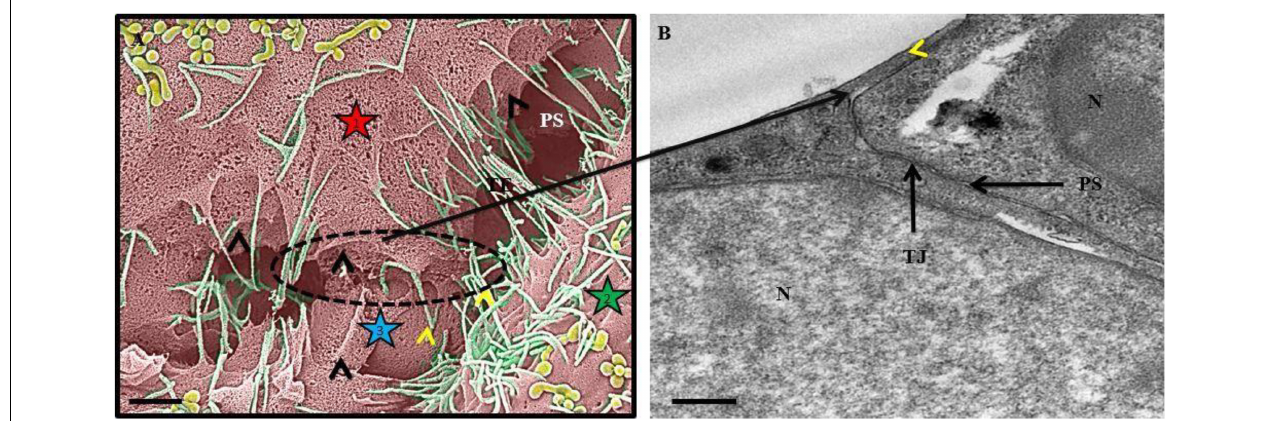
FIGURE 9 | An HRSEM and HRTEM micrograph of tethering nanotubule formation on b.End3 and b.End5 cells. In (A) the HRSEM micrograph depicts the formation of membrane tethers which progress into overlapping leaflets between adjacent b.End5 (BECs). The “ black arrowheads ” indicate direct cell-to-cell communication by way of lateral cytoplasmic protrusions of tethering NTs (TENTs). The “ yellow arrowheads ” indicate the overlapping membranous regions generated by TENTs on the lateral borders between adjacent b.End5, BECs. The stars 1, 2, and 3 designate three different cells (Scale bar = 1,000 nm). In (B) the HRTEM micrograph depicts an apical membranous region on a b.End3 monolayer, establishing an apparent, continuous membrane surface by the fusion of overlapping membrane regions as indicated by the “ yellow arrowhead .” “ N ,” denotes the nucleus of the cell, “ PS ,” denotes the PC space and “ TJ ” denotes the region of tight junction localization (Scale bar = 0.5 µ m).